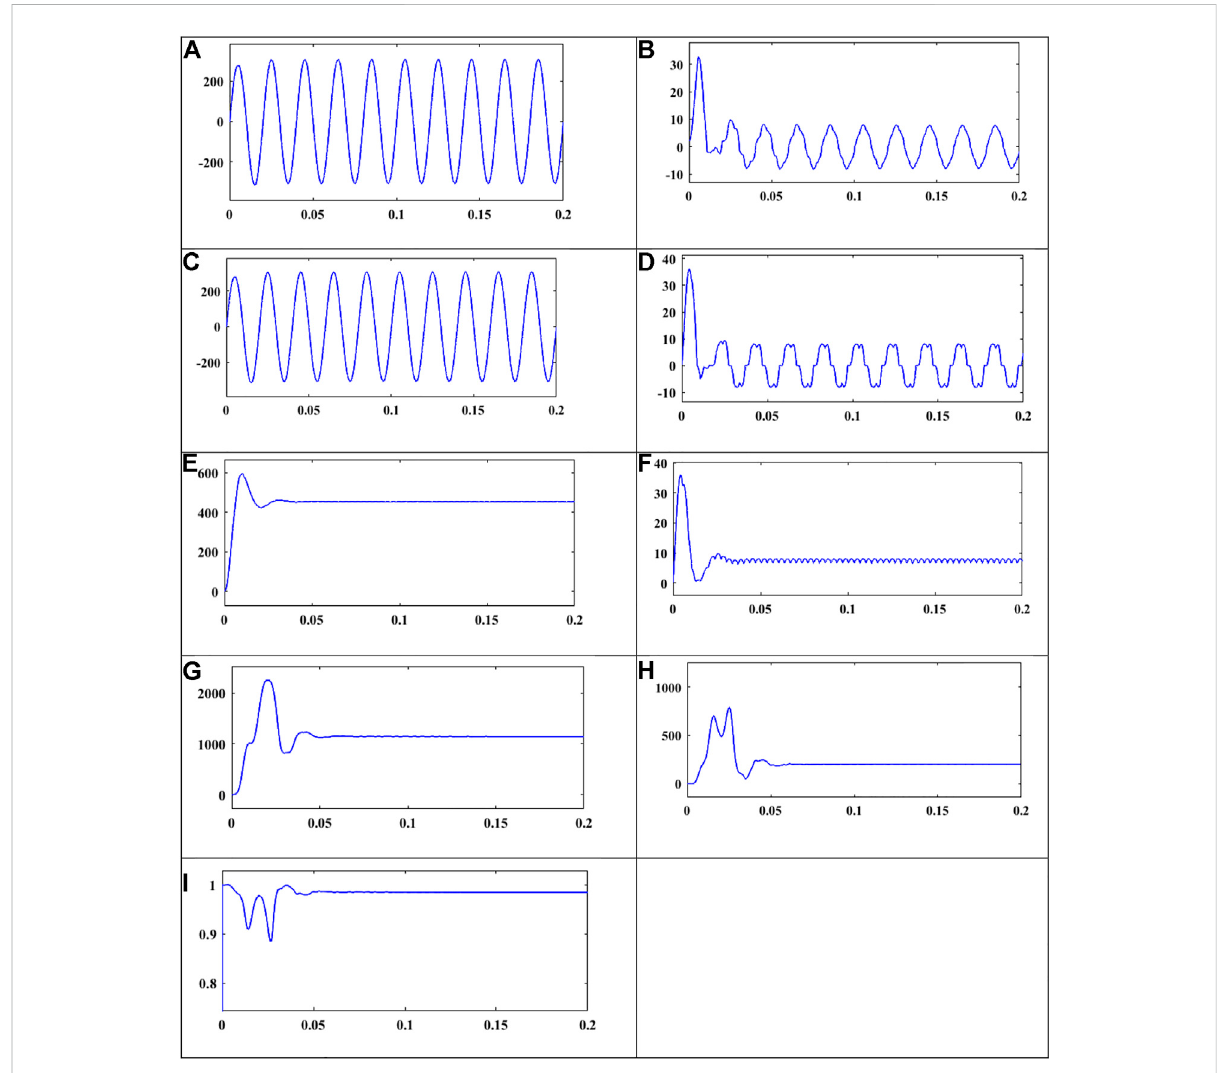
FIGURE 10 Voltage,current,andpowerwaveformforwith fi fth-andseventh-orderharmonic fi lters. (A) Inputvoltage. (B) Inputcurrent. (C) VoltageatPCC. (D) Load current. (E) Voltage after recti fi er. (F) Current after recti fi er. (G) Real power. (H) Reactive power. (I) Power